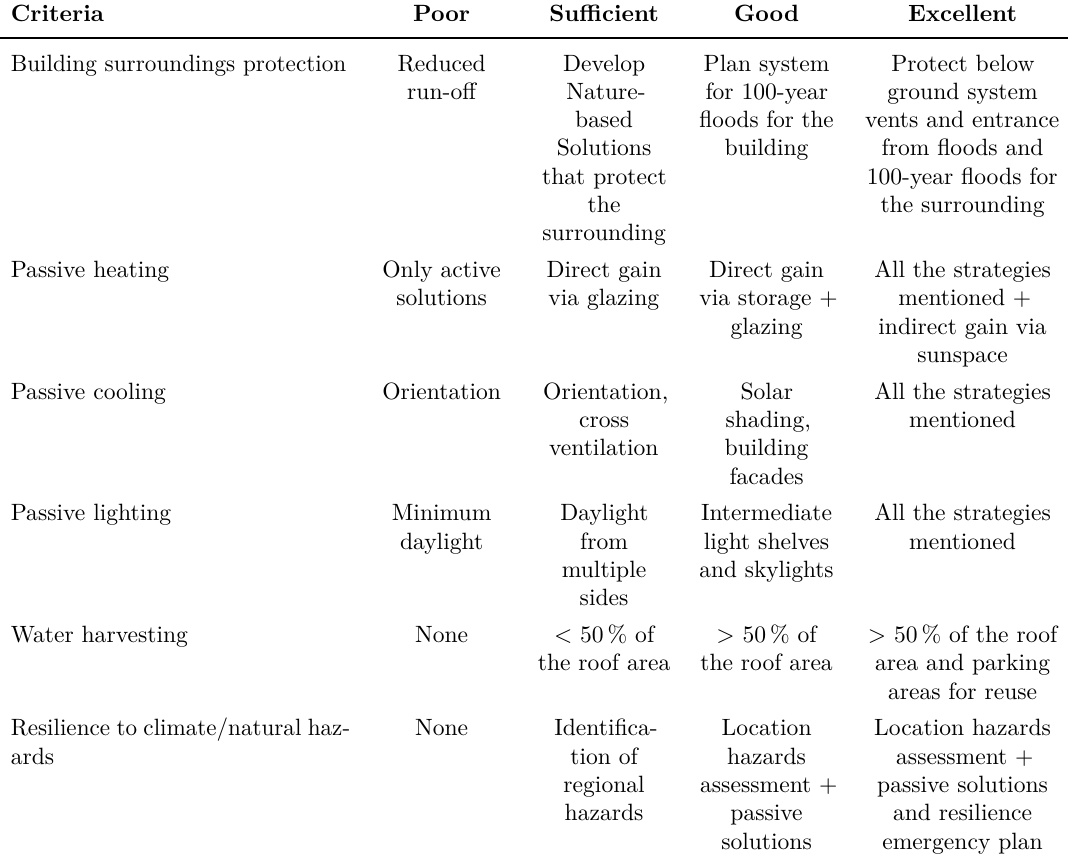
Table 2. Compilation of criteria for the evaluation of qualitative aspects related to